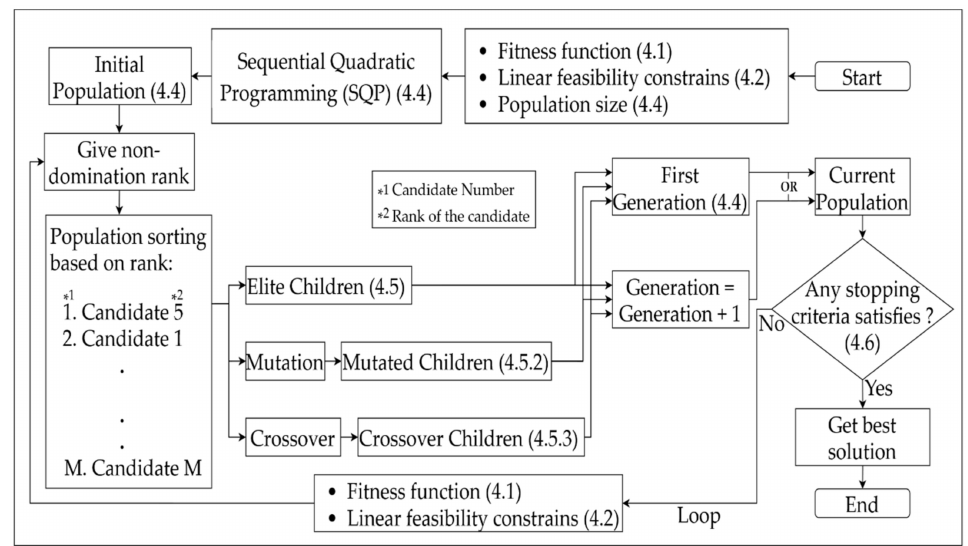
Figure 4. Genetic algorithm implementation for the optimal control problem